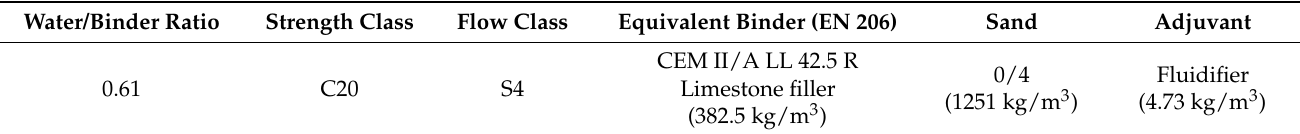
Table 3. Adopted anti-fissuration screed mortar dosage.